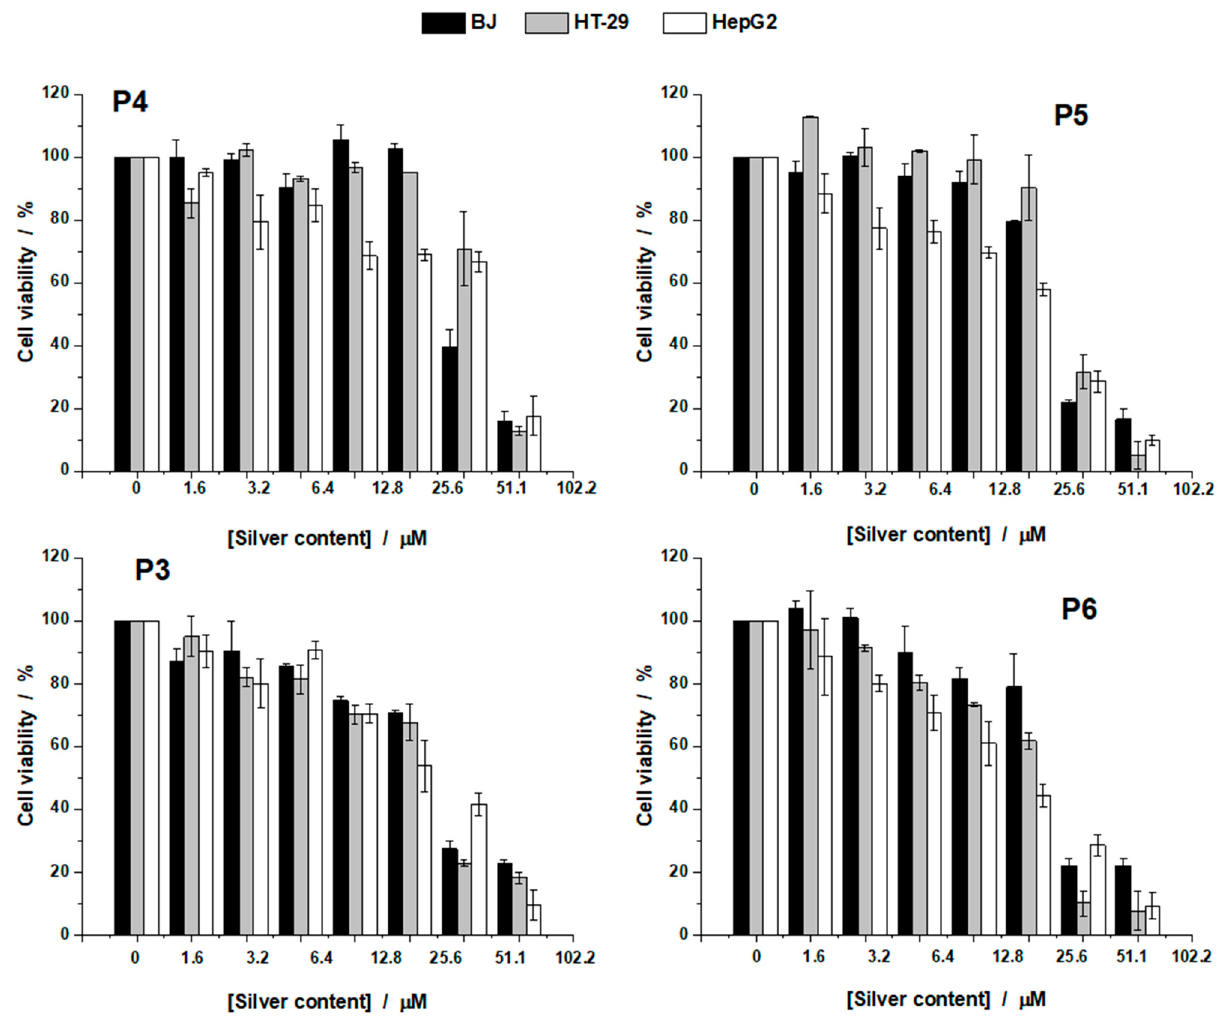
Figure 11. Cell viability of the silver-based materials (P3, P4, P5, and P6) against BJ, HT-29, and HepG2 cells after 24 h of treatment.